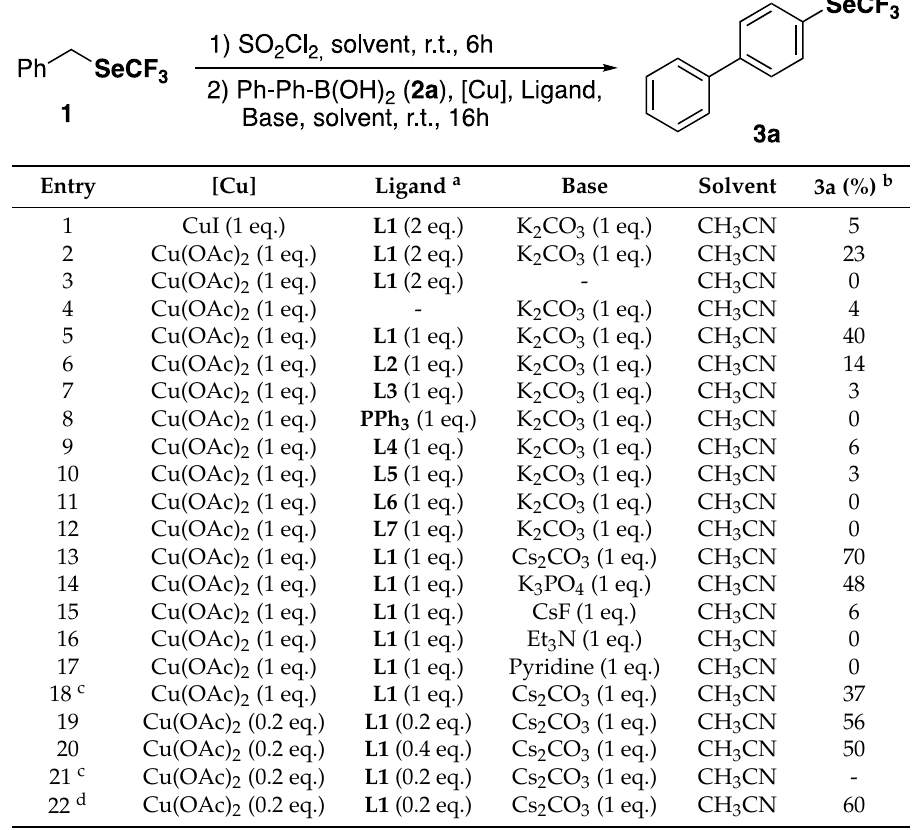
Table 1. Coupling reaction between CF 3 SeCl, generated in situ, and boronic acid 3a .